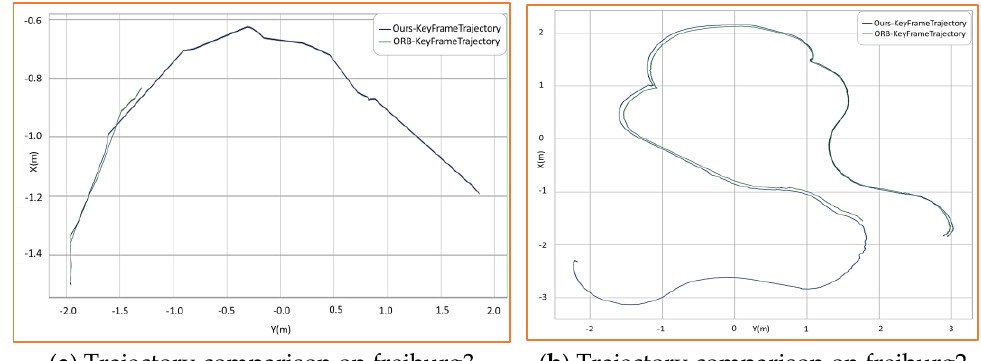
Figure 10. Visual localization trajectory comparison.